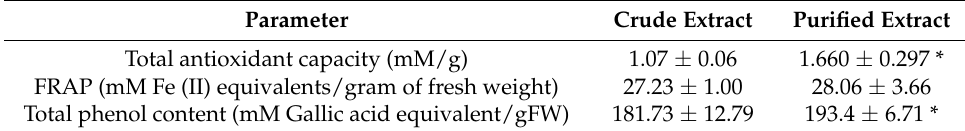
Table 2. Antioxidant activities of the ANT in Oryza sativa L.